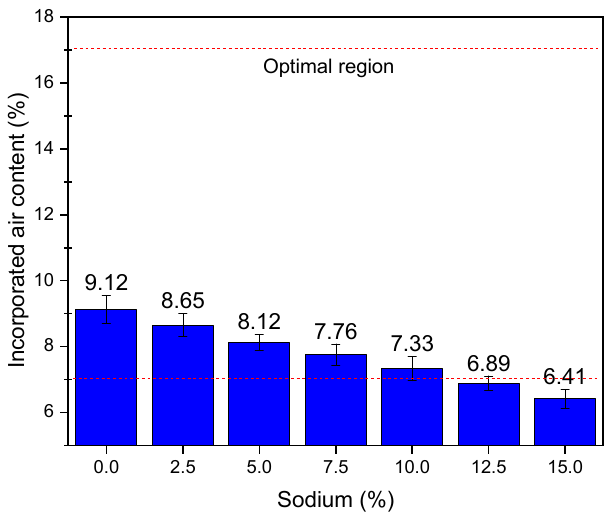
Figure 6. Results of incorporated air content as a function of the sodium content.